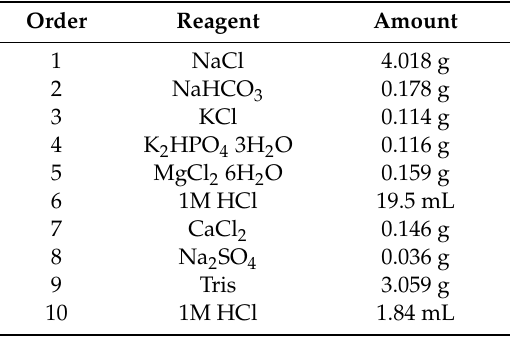
Table A1. Order, amount, and formula of reagents for preparing 500 mL of